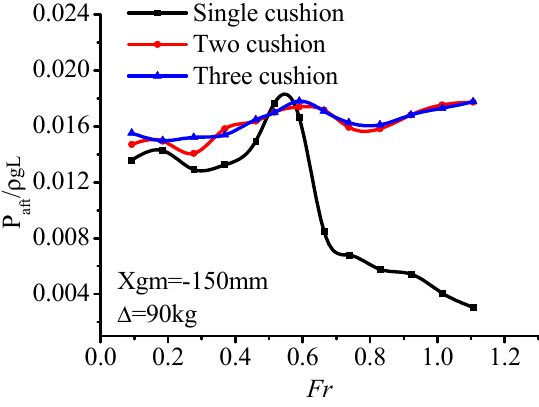
Figure 22. Comparison of dimensionless pressure value measured at point 1.